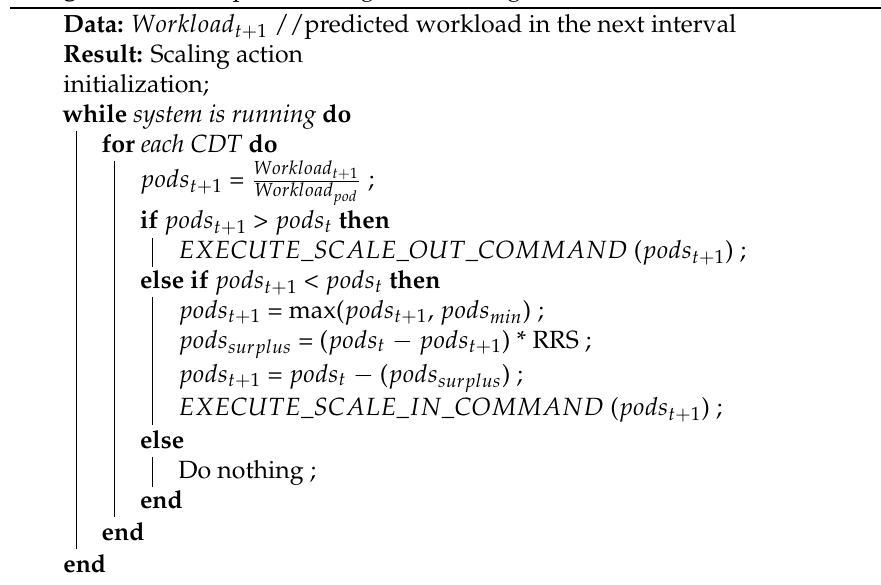
Algorithm 1: Adaption Manager Service